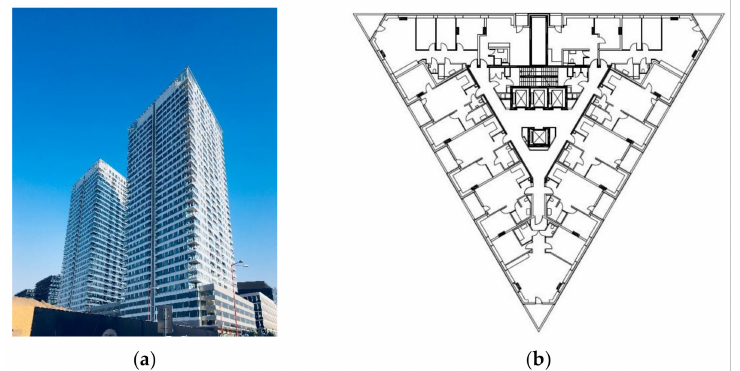
Figure 1. Panorama City buildings (Bratislava, Slovakia): ( a ) 3D view; ( b ) Floor plan of one of the buildings.